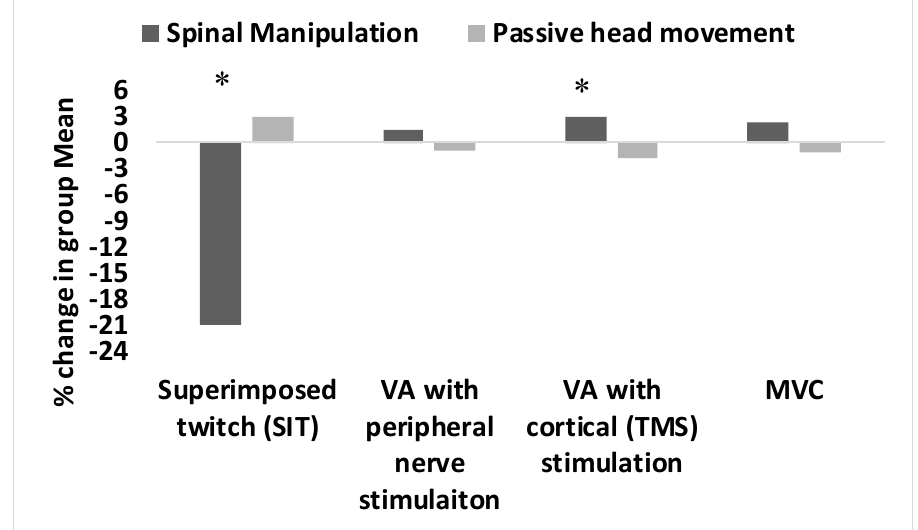
Figure 4. Percentage changes in group mean from pre to post of superimposed twitch (SIT), Voluntary activation (VA) with peripheral nerve (electrical) stimulation ( N = 11) and cortical (TMS stimulation ( N = 18) and MVC in the spinal manipulation (intervention) and passive movements (control) sessions across all participants. * represents p < 0.05.